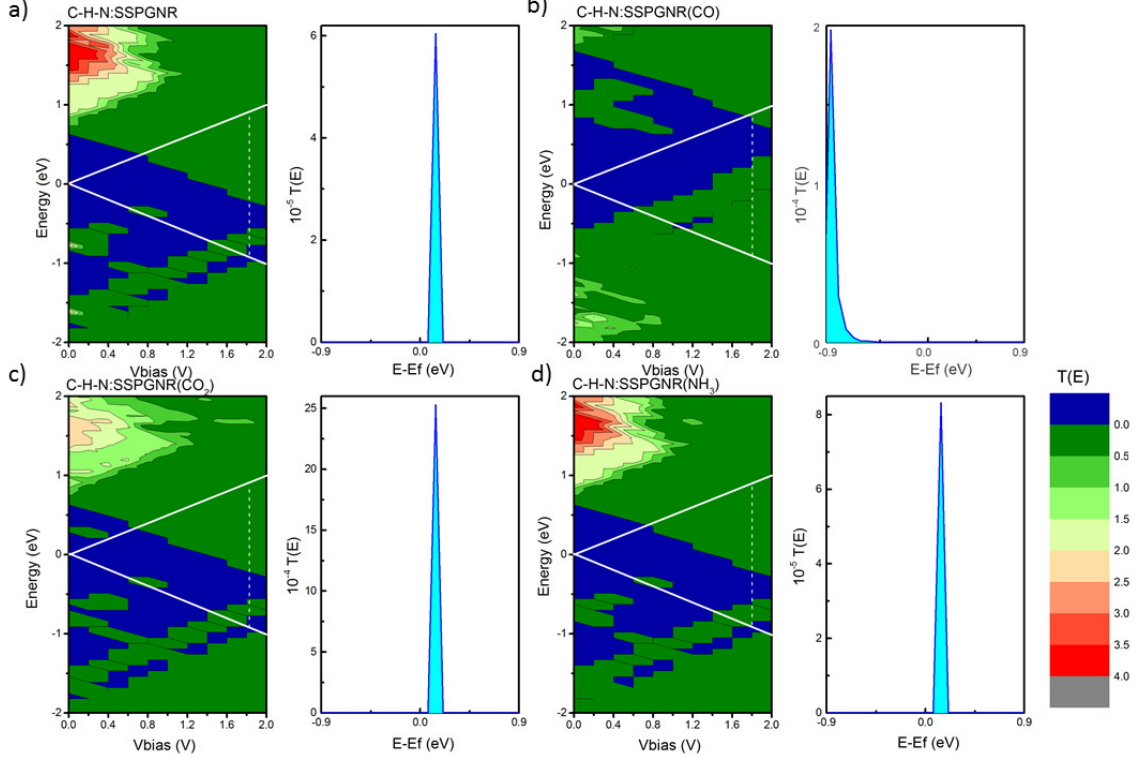
Figure 7: Left-hand panels: The contour of the bias-dependent transmission T(E,Vb); Right-hand panels: Transmission coefficient at 1.8 V bias of four structures: a) C-H-N:SSPGNR, b) C-H-N:SSPGNR(CO), c) C-H- N:SSPGNR(CO 2 ) and d) C-H-N:SSPGNR(NH 3